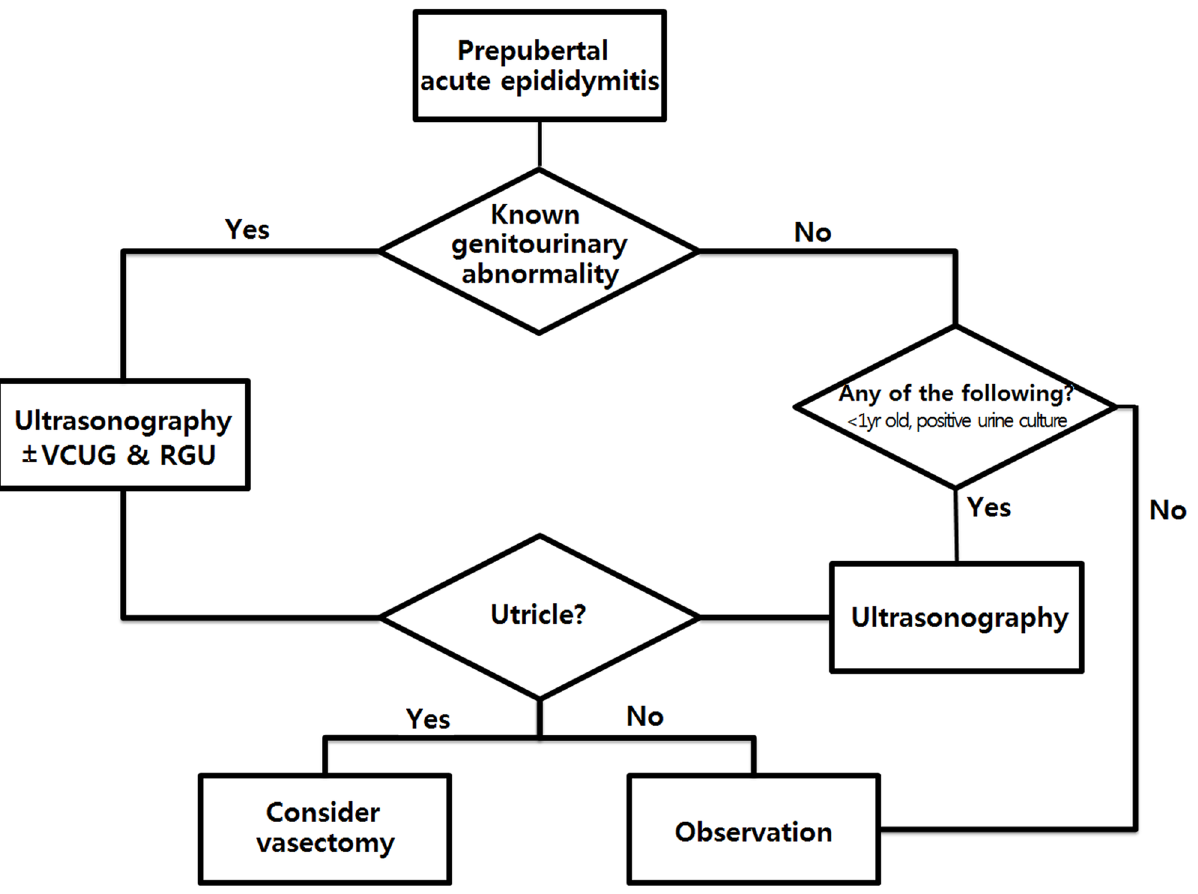
Fig 4. Algorithm for managing the treatment of prepubertal epididymitis; VCUG, voiding cystourethrography; RGU, retrograde urethrography.